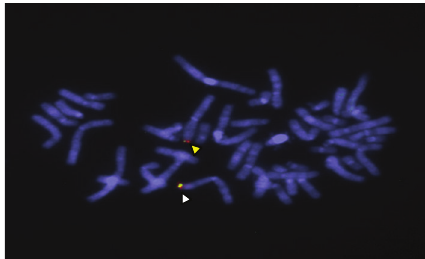
Figure 2: FISH analysis of metaphase cells using two BAC probes. The fluorescent signals identify the two homologues of chromosome 3 in cells of the proband. The orange and green signals (indicated by the yellow arrow head) show hybridisation of the BAC clones RP11- 203L11 and RP11-739I20, respectively, to their normal sequences. The lower homolog shows a yellow signal, created from the combination of orange and green signals (indicated by a white arrow head), which is consistent with two tandem duplications on the same